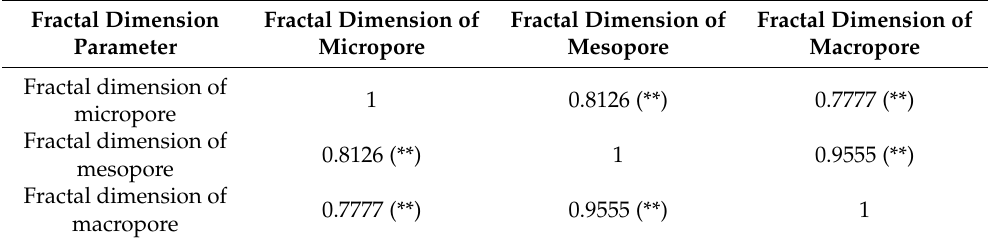
Table 9. Analysis of pore size fractal dimension.